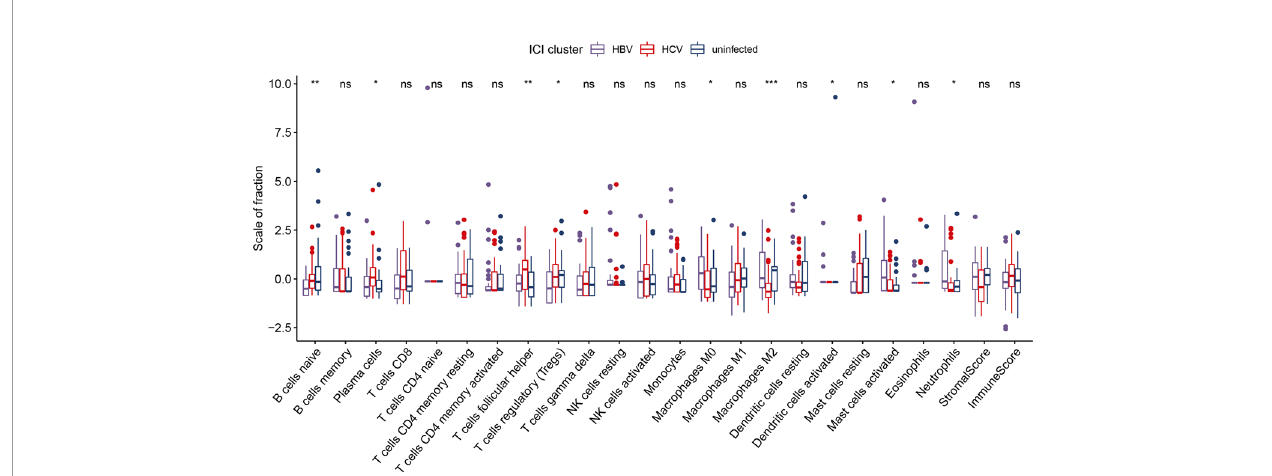
FIGURE 4 | The fraction of tumor-in fi ltrating immune cells in HCC strati fi ed by etiology. ns, not signi fi cant *p < 0.05; **p < 0.01; ***p <